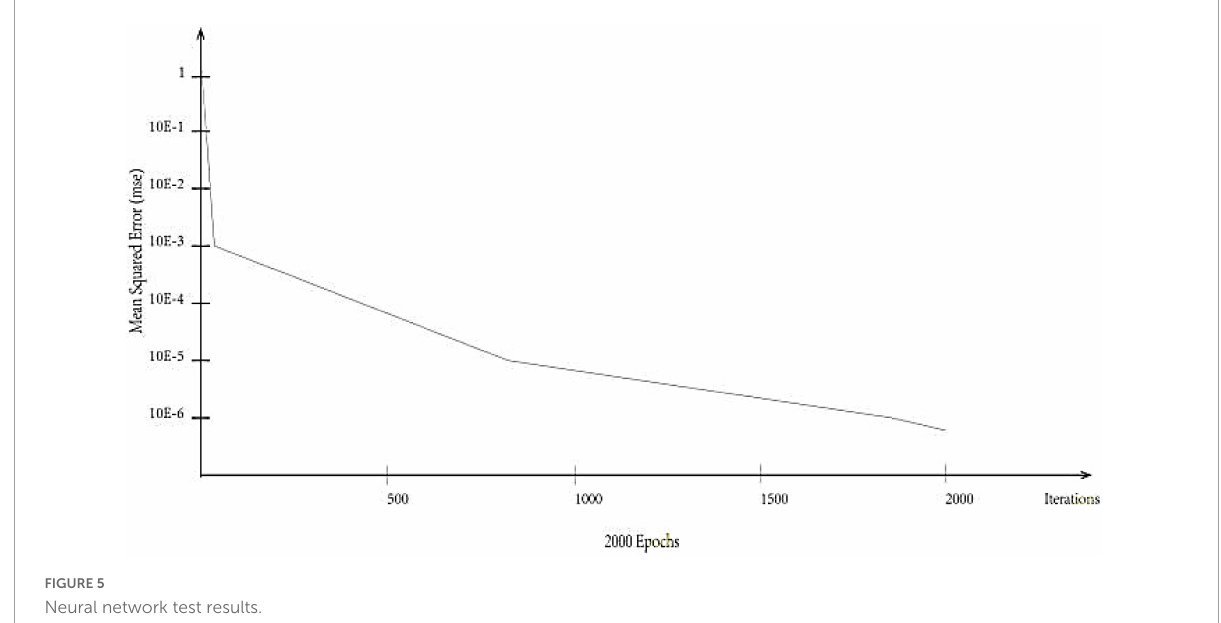
FIGURE5 Neural network test results.